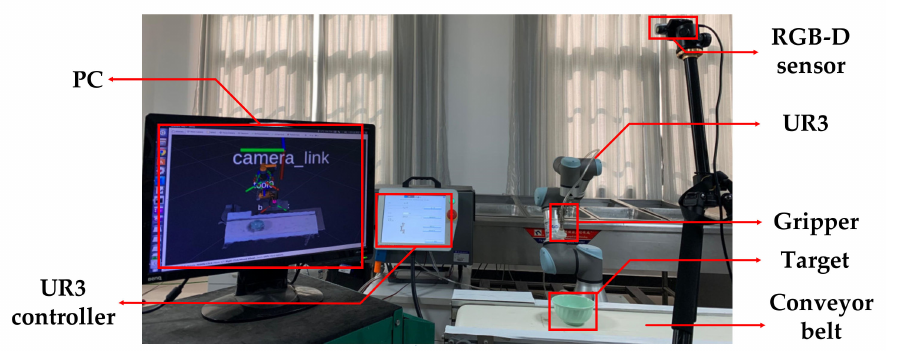
Figure 19. Grabbing experimental scenes.